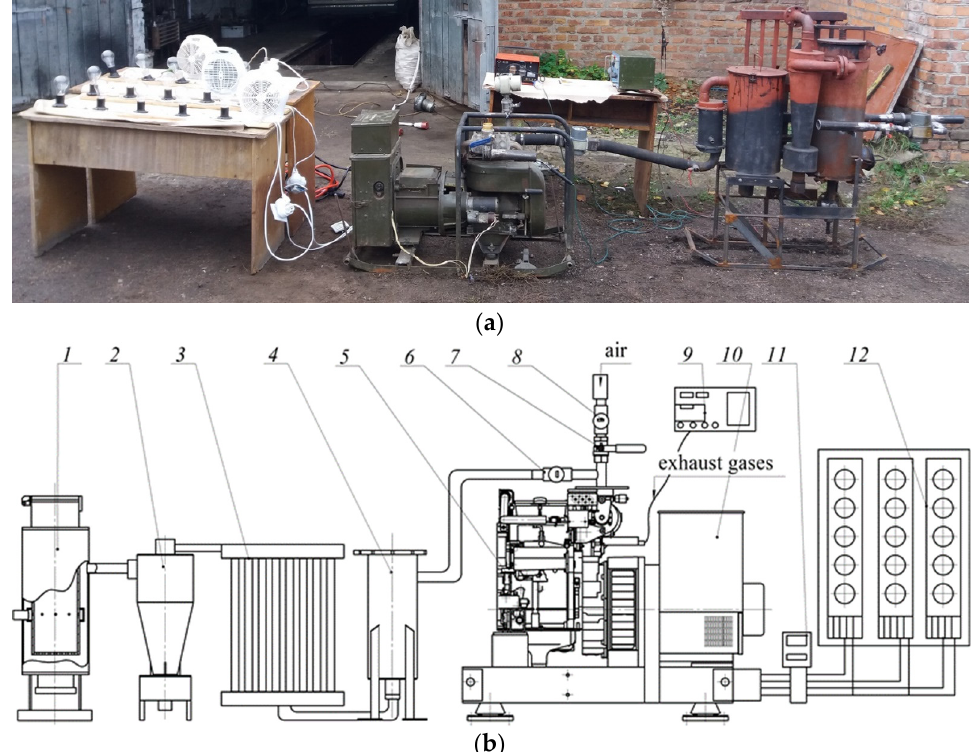
Figure 3. General view ( а ) and a scheme ( b ) of plant number 2 for conducting research: 1—a downdraft gasifier; 2—a filter for intermediate gas purification; 3—a refrigerator; 4—a filter for a final gas purification; 5—an internal combustion engine; 6—a gas meter; 7 –a mixer for regulating the air supply into the engine; 8—an air meter; 9—an analyzer of the chemical composition of exhaust gases; 10—an